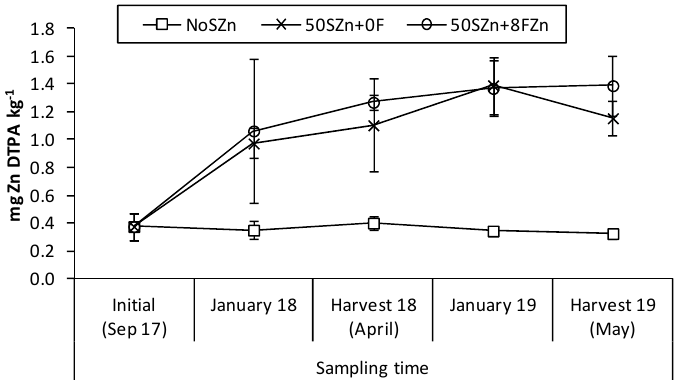
Figure 1. Zn DTPA concentration into topsoil of the study area as affected by the interaction ‘sampling time (five times) * Zn application (3 treatments: NoSZn, 50SZn + 0F and 50SZn + 8FZn)’. Error bars indicate standard error ( n = 3). Different letters mean significant differences between means according to LSD test ( p ≤ 0.05).